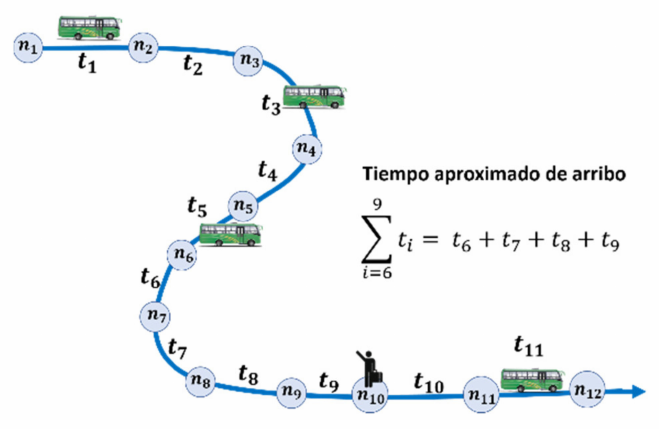
Figure 10. The calculation of the arrival